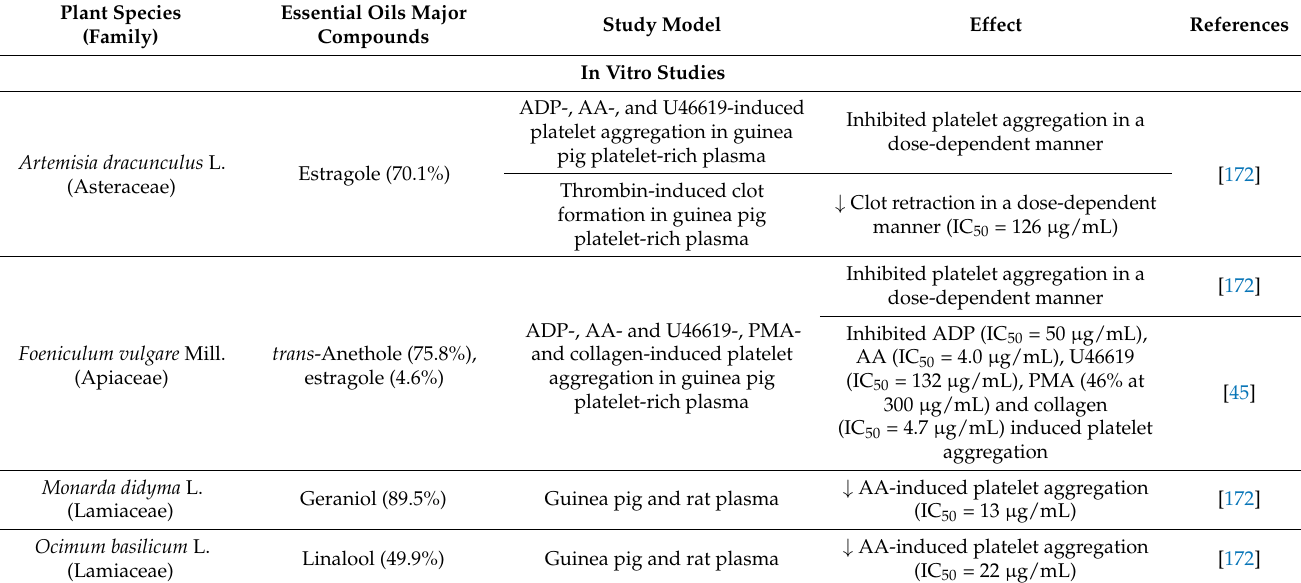
Table 3. Essential oils with antiplatelet aggregation